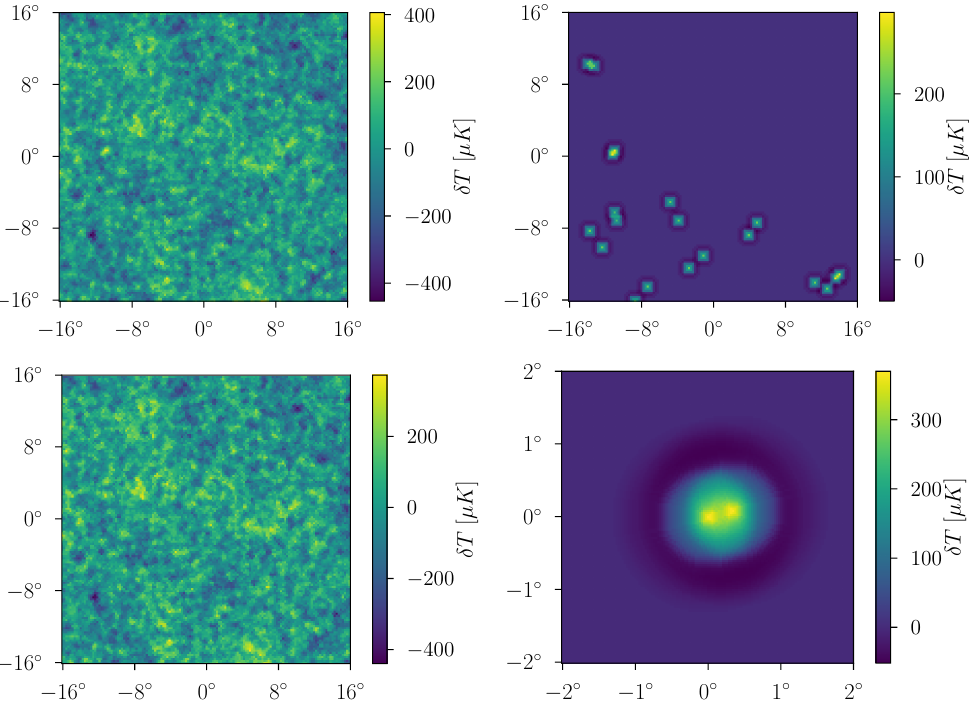
Figure 5 . Local patches of (upper-left) CMB + PHS, (upper-right) PHS, and (lower-left) CMB, generated within a region of longitude = [ − 16 ° , 16 ° ] and latitude = [ − 16 ° , 16 ° ] centered at ( θ, φ ) = ( π/ 2 , 0) and projected onto the Cartesian coordinates ( 140 × 140 pixels) using N = 256 . The side shape of PHS is based on the η = 160 Mpc and g = 6 benchmark, and the separation distance is ∗ r sep = 0 ∼ 10 pixels. In total, ten PHS signals are injected using a flat distribution. (lower-right) A higher-resolution image of the PHS with separation ≈ η 4 using N = 2048 , plotted within a ∗ / side region of longitude = [ − 2 ° , 2 ° ] and latitude = [ − 2 ° , 2 ° ] centered at ( θ, φ ) = ( π/ 2 , 0) projected onto the Cartesian coordinates ( 123 × 123